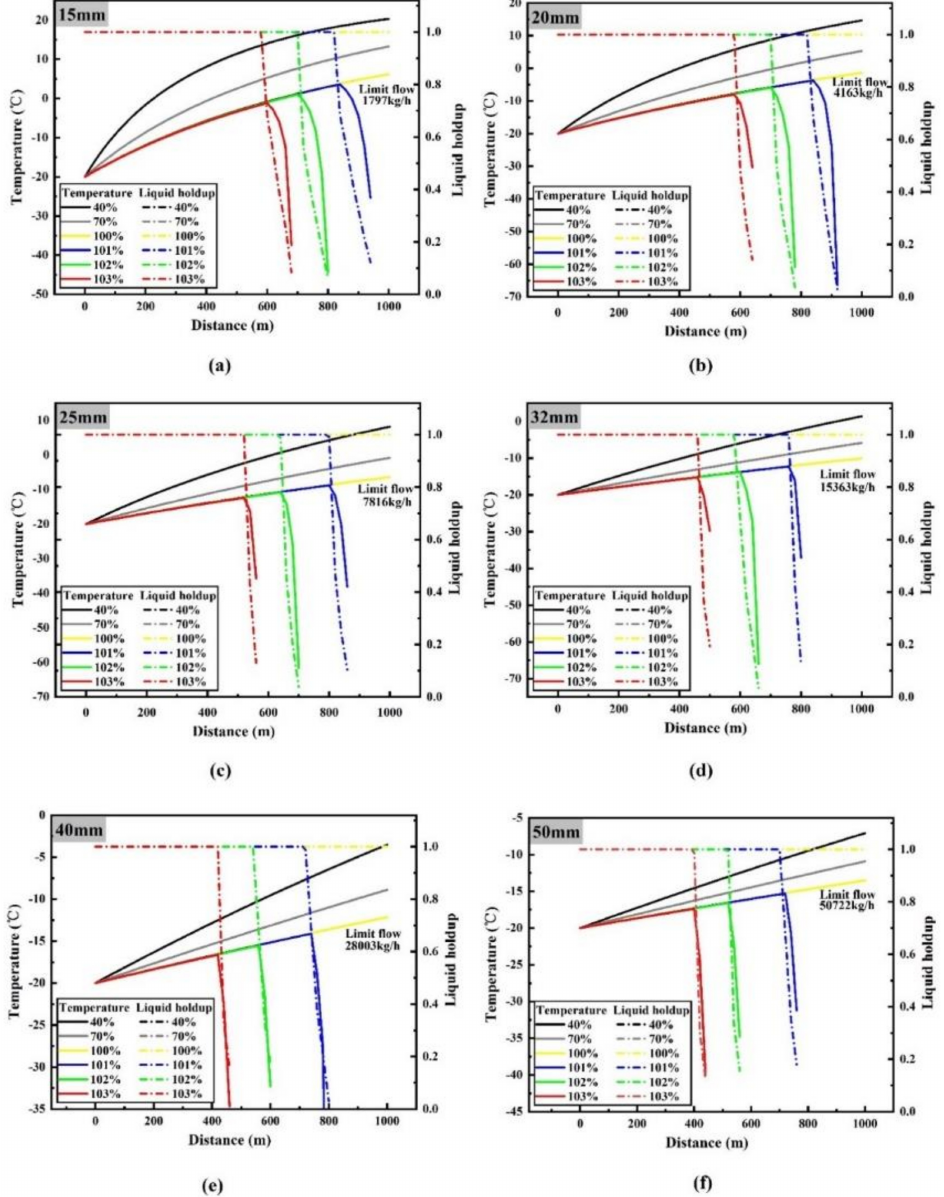
Figure 3. Curves of CO 2 temperature (solid line) and liquid holdup (dotted line) with depth at di ff erent flow rates under di ff erent pipe diameters: ( a ) 15 mm diameter; ( b ) 20 mm diameter; ( c ) 25 mm diameter; ( d ) 32 mm diameter; ( e ) 40 mm diameter; ( f ) 50 mm